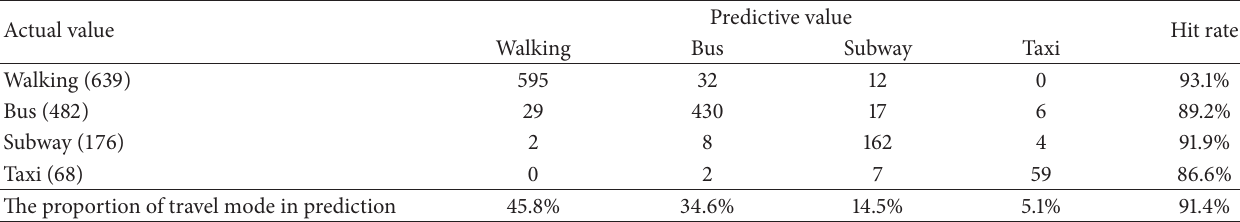
Table 4: The hit rate of the MNL model for migrant workers.